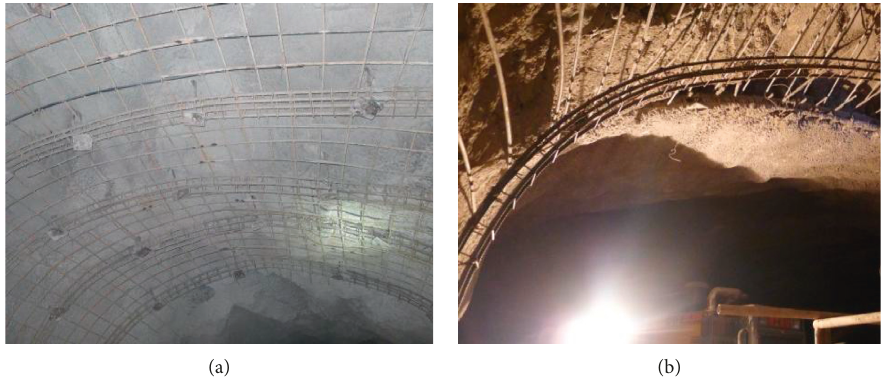
Figure 3: Support status of the main haulage roadway. (a) Bolt-mesh support and (b) steel arch